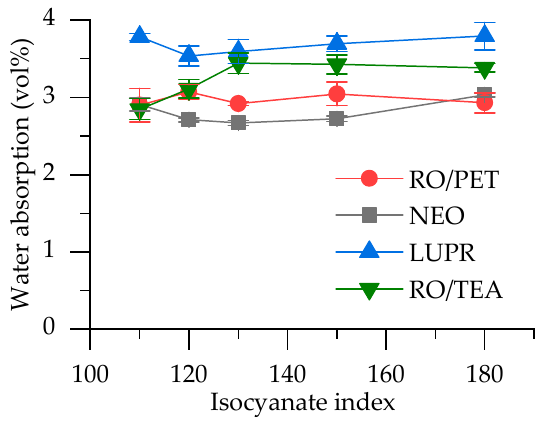
Figure 5. Water absorption after seven days of immersion.